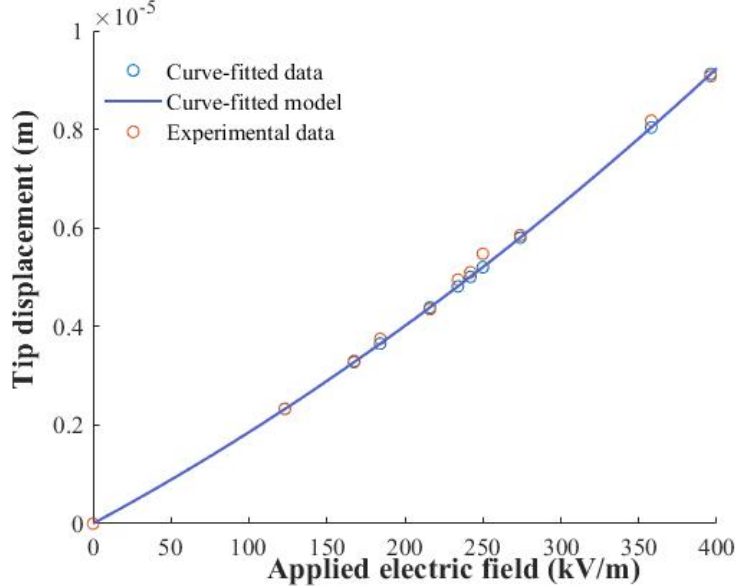
Figure 6. Comparison of experimental and optimized tip displacement values.